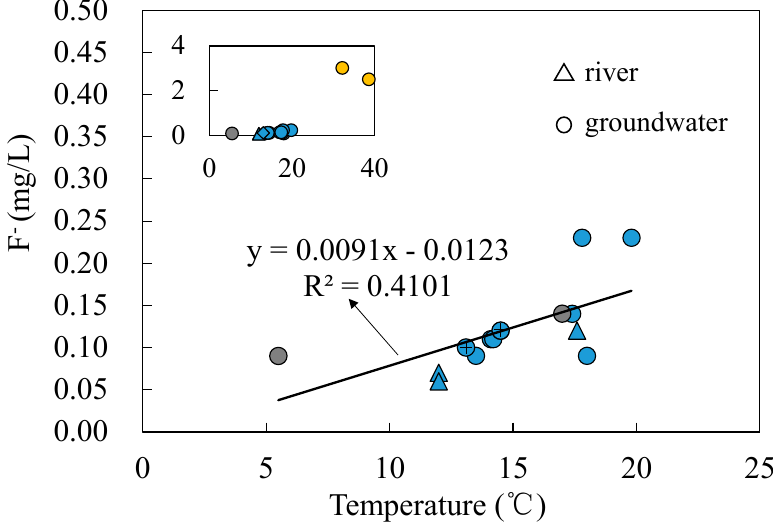
Figure 3. Relationship between F ion and temperature excluding the hot spring at Zhanggu. Triangles are river samples, circles are groundwater samples, and circles with a cross are the water samples at the borehole ZK. Yellow represents the spring at Zhanggu, grey color represents the spring at Kemu, and blue represents the rest.